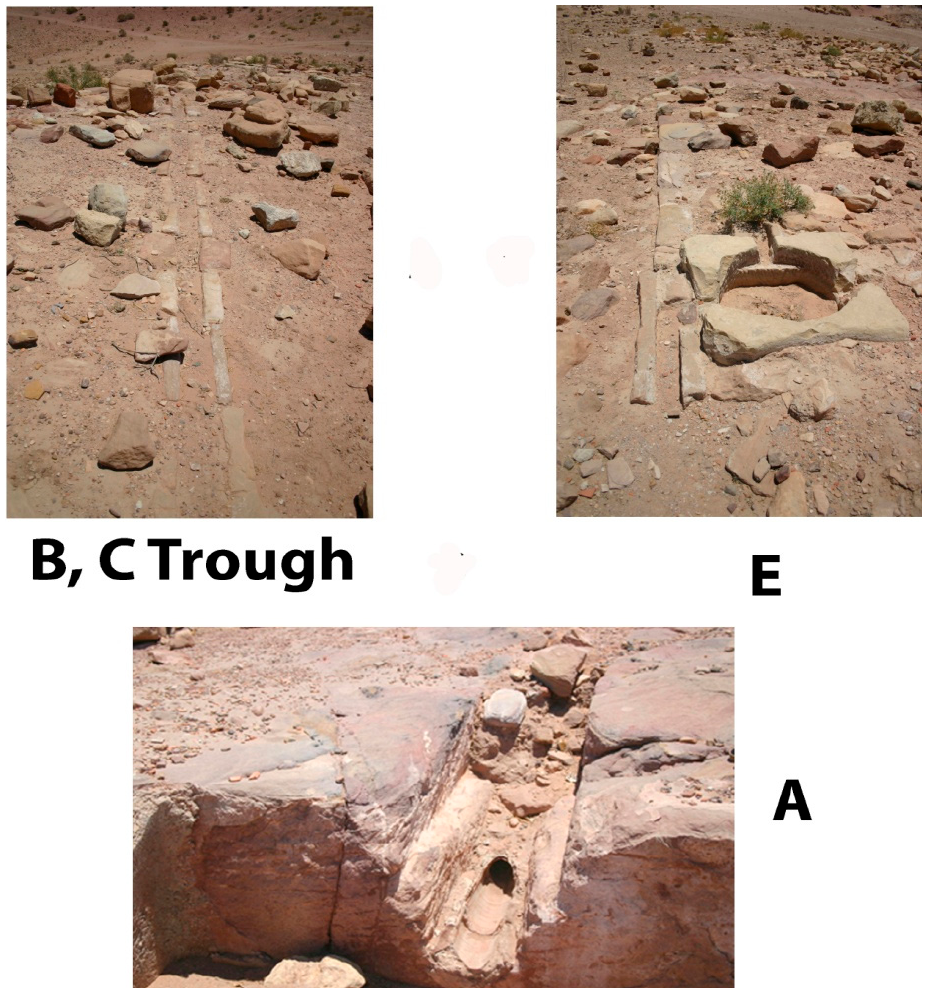
Figure 20. Details of pipeline components located above the Great Temple area. Pipeline ( A )